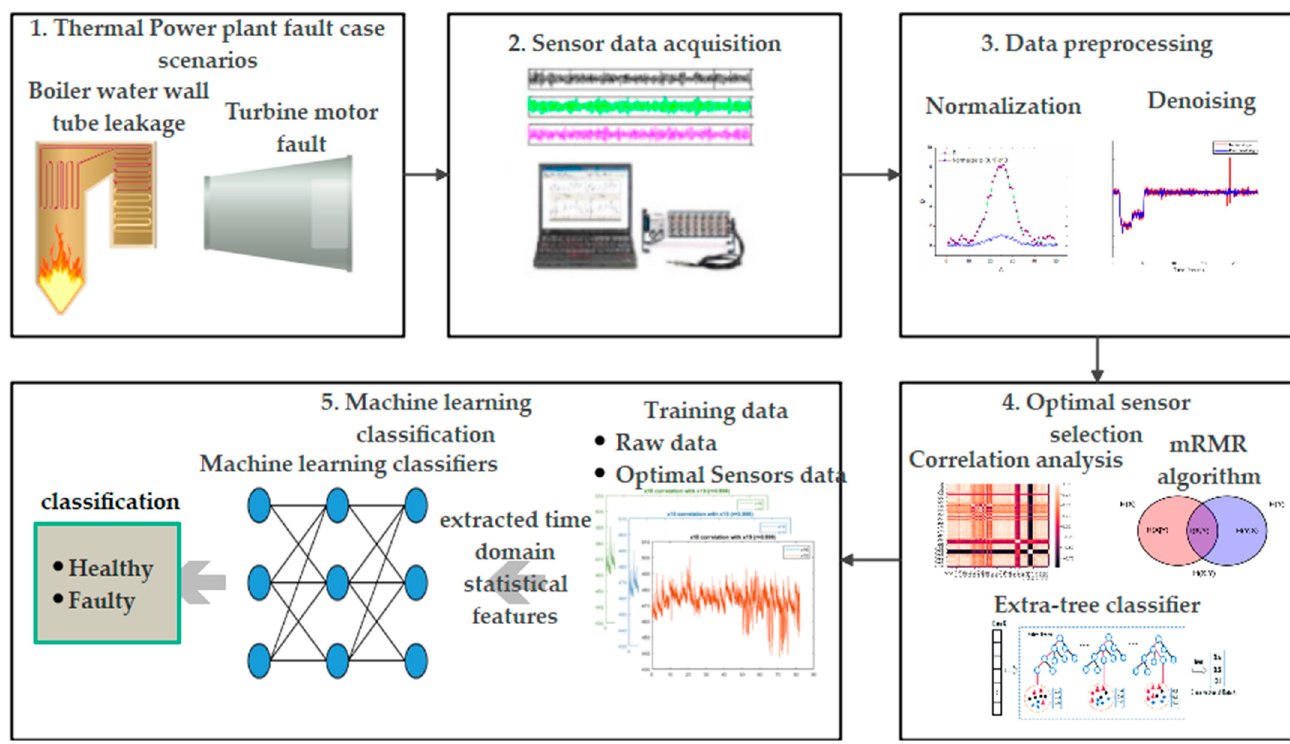
Figure 5. Detailed summary of the proposed approach.